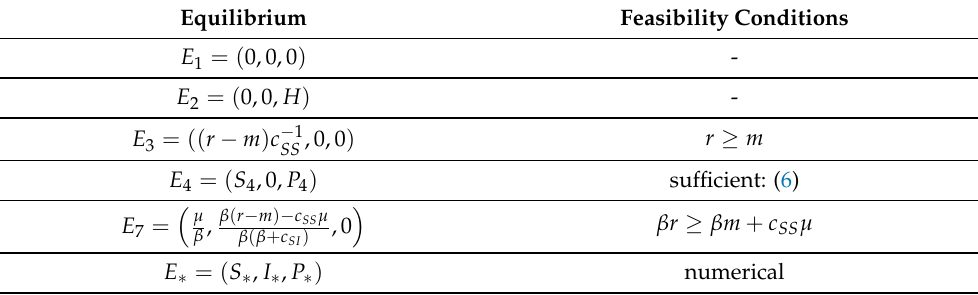
Table 2. Equilibria E k = ( S k , I k , P k ) of (1) and their feasibility.